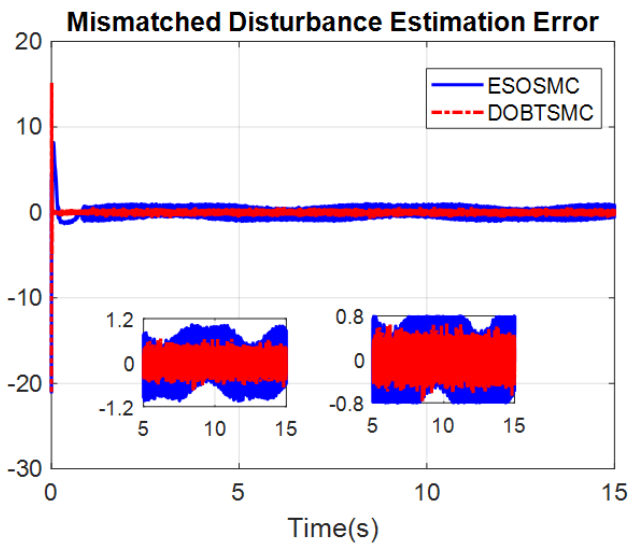
Figure 12. Mismatched disturbance estimation error of ESOSMC and DOBTSMC.